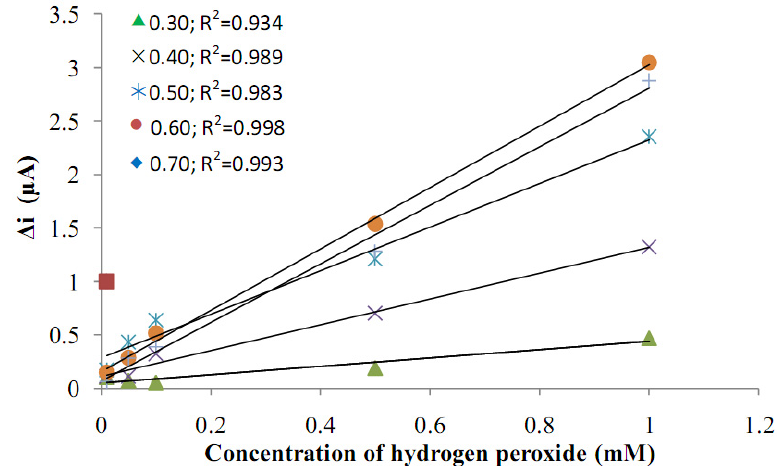
Figure 4. The effect of potential on the response of the Pt/Pani-Pvs electrode to hydrogen